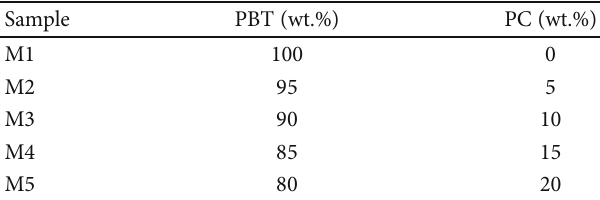
Table 1: Compositions of the samples (wt.%).